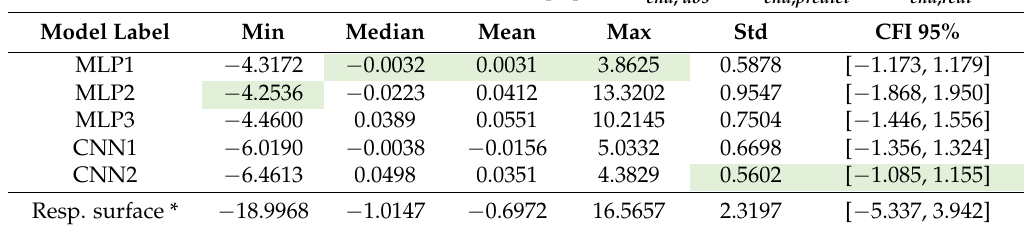
Table 3. Basic statistical indicators of SoC-at-destination ( SoC end ) predictions for both response surface- and NN-based energy demand